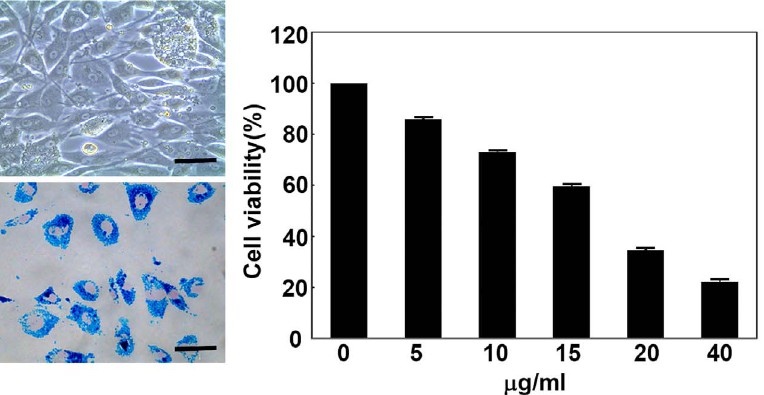
Figure 3. BM-EPC SPIO labeling. Photomicrographs showing BM-EPCs labeled with super-paramagnetic iron oxide nanoparticles (SPIO) in vitro pre-incubation ( a ), post-incubation ( b ). Bar=140 m m. Prussian blue staining showing that the cell cytoplasm contained a large number of SPIO (blue color) and the nucleus displayed pink after nuclear fast red staining. Bar graph showing quantification of cell viability following BM-EPC incubation with various SPIO concentrations of 5 m g/ml, 10 m g/ml, 15 m g/ml, 20 m g/ml, 40 m g/ml.